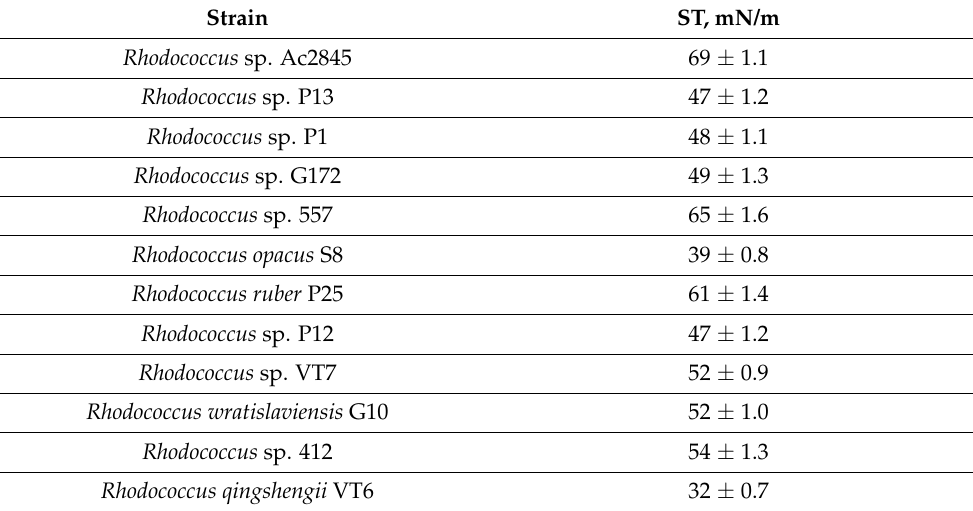
Table 2. Surface tension of the culture liquid of carbohydrate-oxidizing